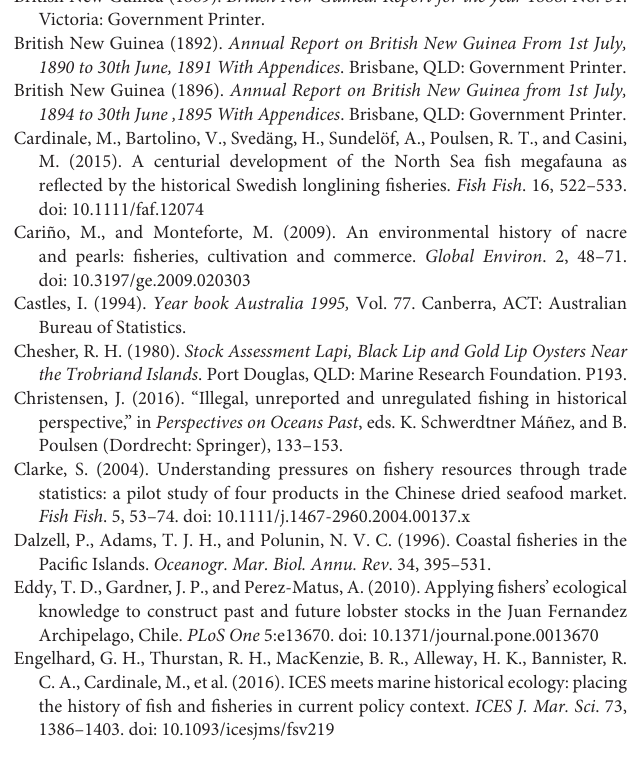
Supplementary Figure 1 | Annual weight and value of (A,B) total mother-of-pearl (MoP) exports for Papua New Guinea differentiated as (C,D) trochus ( Rochia nilotica ), (E,F) pearl oysters ( Pinctada spp.), and (G,H) greensnail ( Turbo marmoratus ), comparing data from Glucksman and Lindholm (1982) (black lines) with data from our dataset (grey lines). Supplementary Figure 2 | Annual (A) weight and (B) value tonne − 1 of trochus ( Rochia nilotica ) production from the Australian mother-of-pearl (MoP) fishery operating in the Great Barrier Reef region between 1912 and 1962 ( Nash, 1985) compared with total MoP exports for Papua New